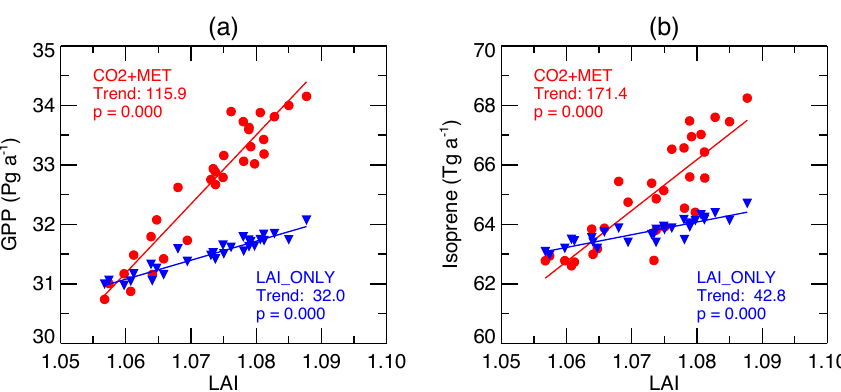
Figure 7. Responses of (a) GPP and (b) isoprene emissions to the changes in the annual average LAI at the north of 30 ◦ N for simulations CO2_MET (red) and LAI_ONLY (blue). Both GPP and isoprene emissions are the sum of all PFTs. Isoprene is simulated with the PS_BVOC scheme. Units of trends are (a) Pg Ca − 1 LAI − 1 and (b) Tg Ca − 1 LAI − 1 . The spatial distribution of GPP and isoprene changes is shown in Fig. S2.